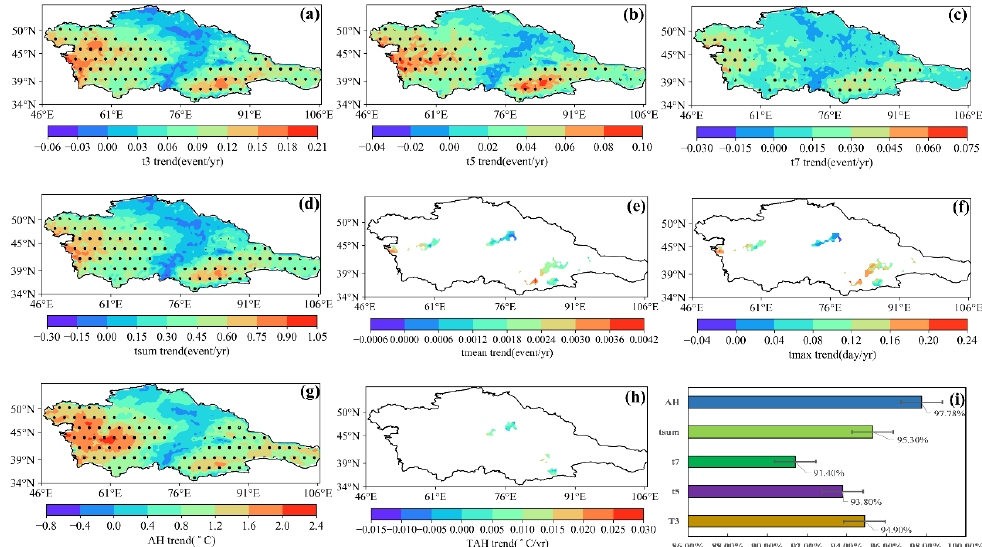
Figure 5. ( a – h ) Spatial trend and significance tests for each index of CDHWs in Central Asia; ( i ) proportion of affected areas which have increased according to the trends of some indicators (black point highlights the 95% significance